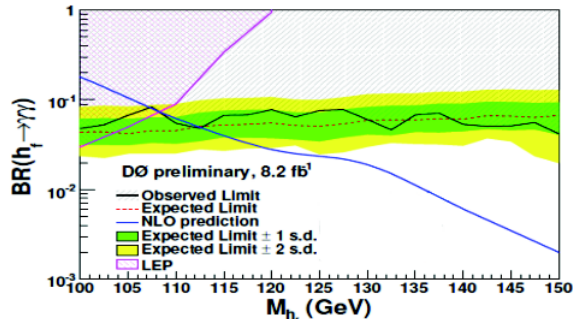
Fig. 5. Observed and expected 95% C.L. measured by the D0 experiment using a luminosity of 8 . 2 fb − 1 in the H → γγ channel for a fermiophobic Higgs boson of di ff erent